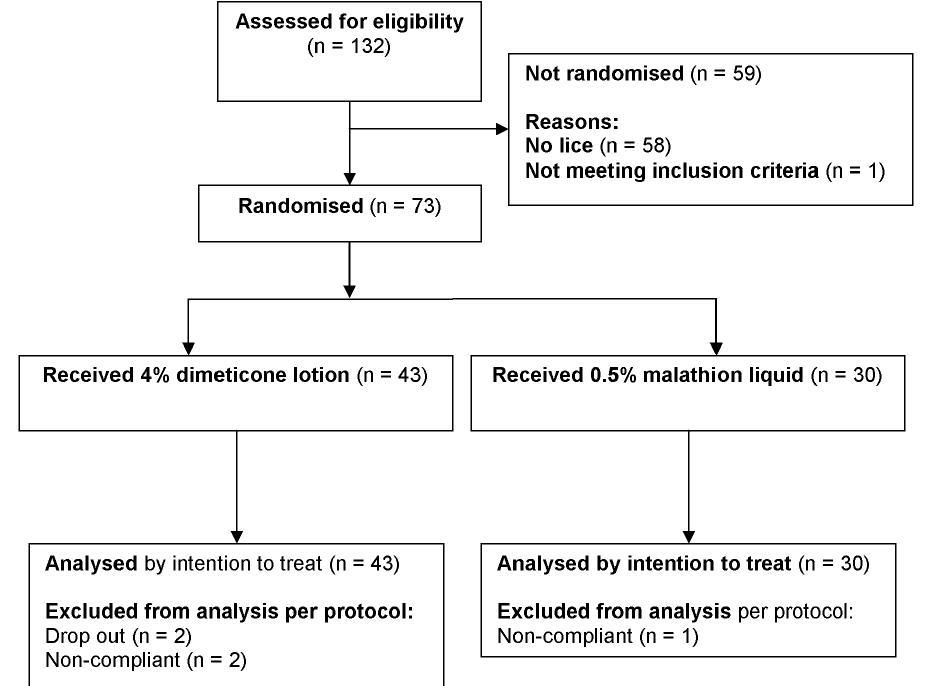
Figure 1. CONSORT flowchart of participants through the study